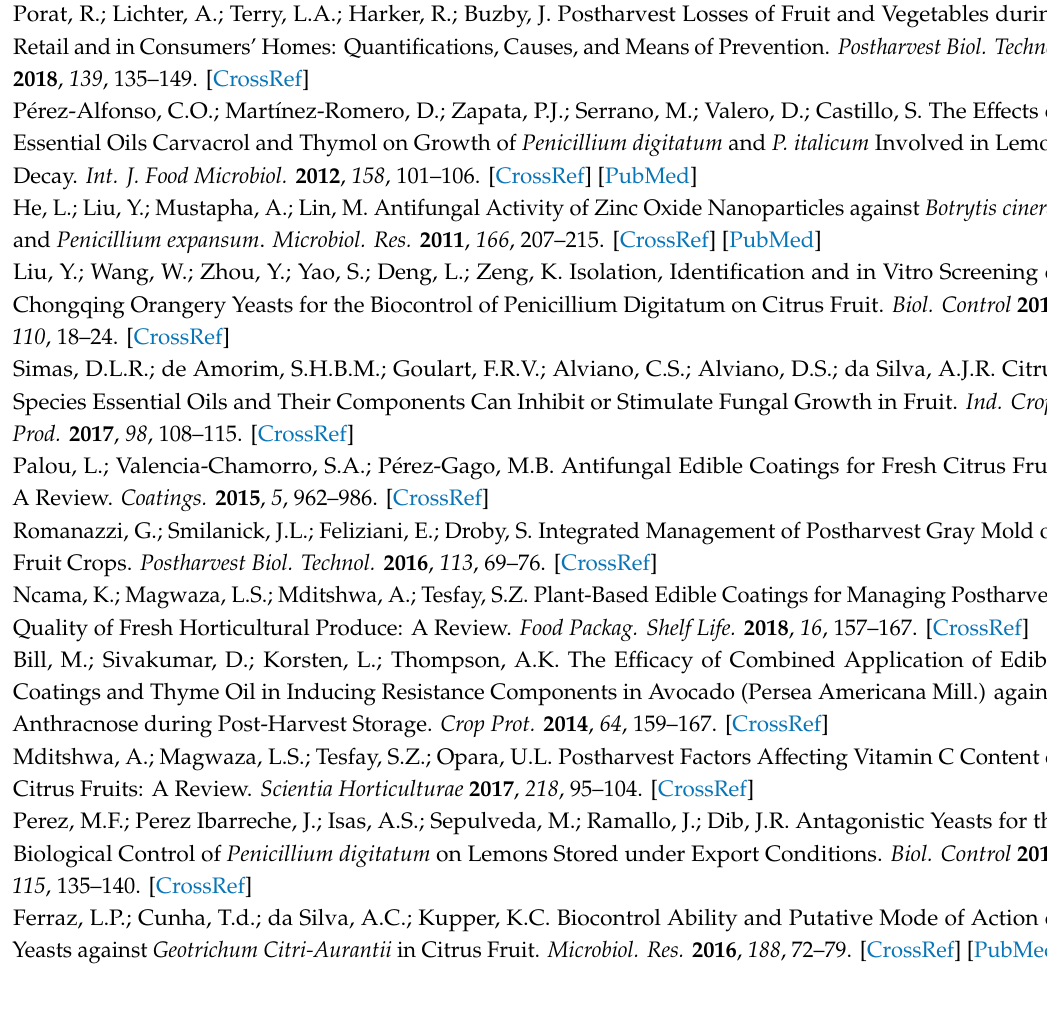
Supplementary Materials: Figure S1: The IC50 values determined by polynomial equation for MEO (a), BEO (b), and LEO